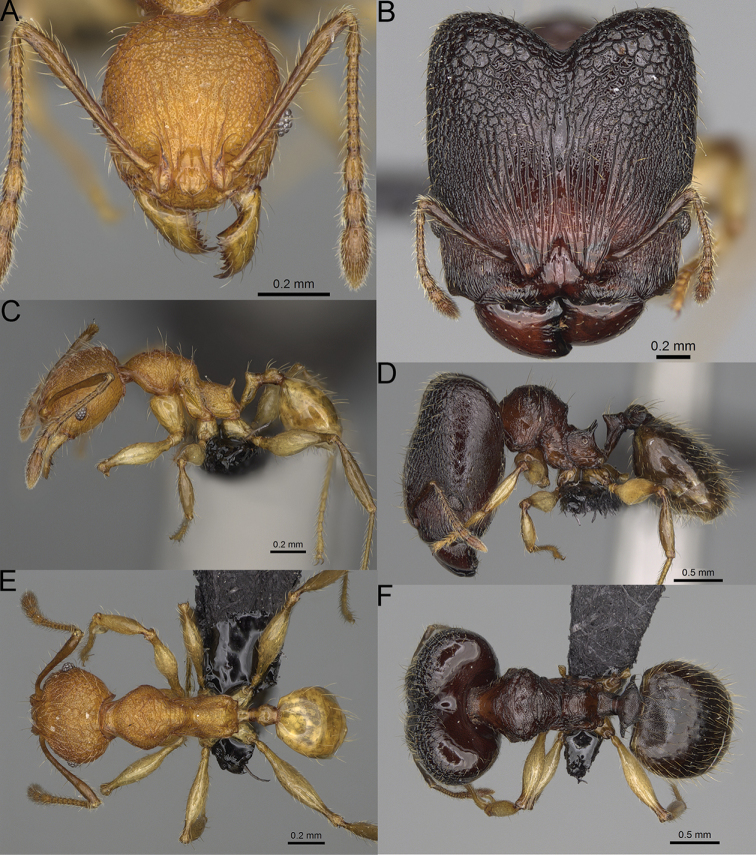
Pheidole
makirovana sp. nov., full-face view (A), profile (C), and dorsal view (E) of paratype minor worker (CASENT0923174) and full-face view (B), profile (D), and dorsal view (F) of holotype major worker (CASENT0231059).